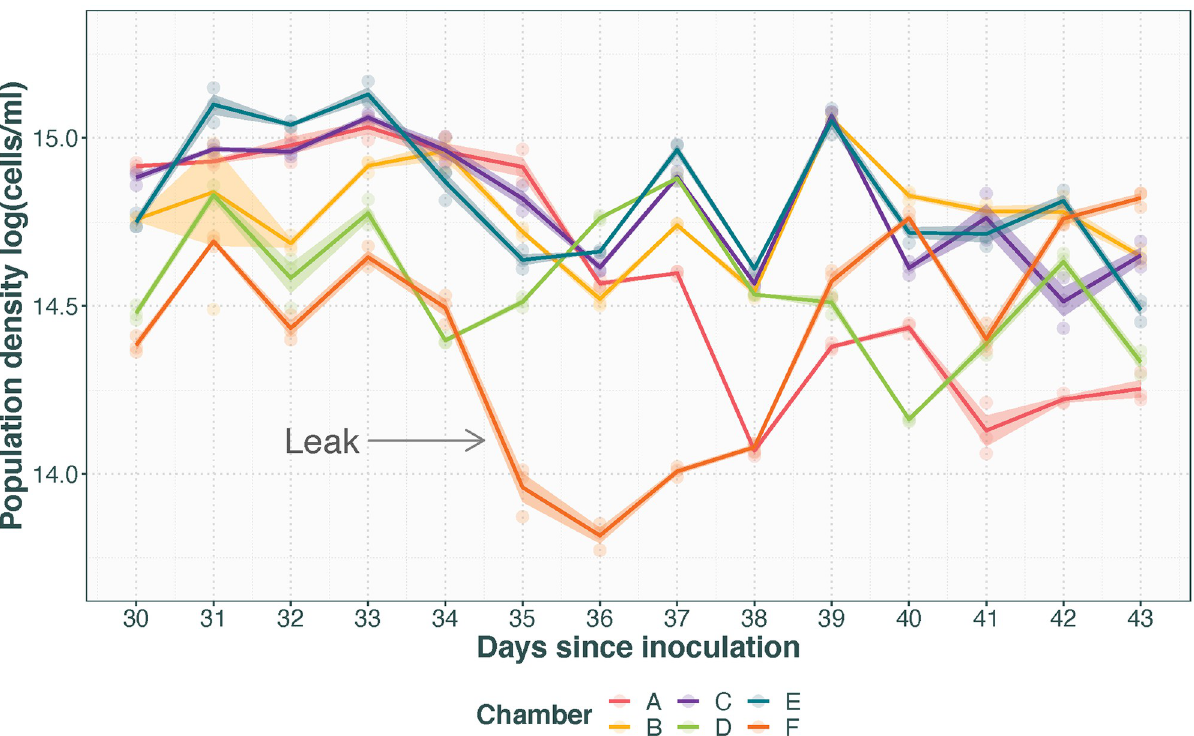
Fig 3. Population density with time after a major leak. Transparent points represent technical replicates with opaque lines for population average with standard error. The leak caused overdilution of chamber F between days 34 and 35 (indicated by arrow), compared to the unaffected chambers A–